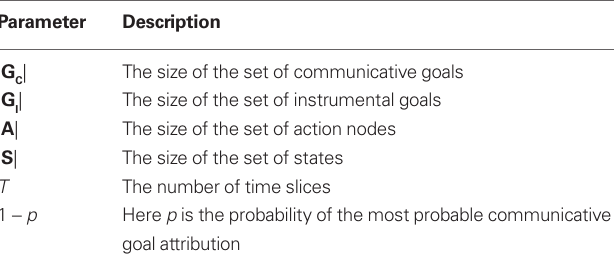
Table 2 | Overview of complexity results and open questions for r eceiver problem (top) and S ender problem (bottom).